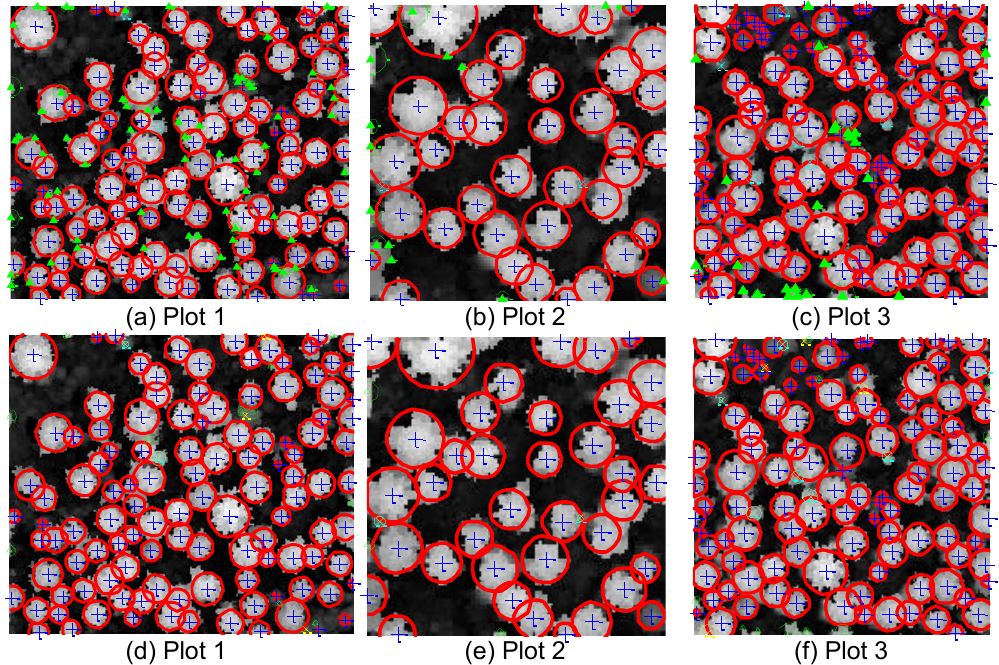
Figure 5: Detection results of the proposed model with estimated parameters compared with traditional local maxima filtering on experimental forest plots. (a)-(c) show the local maxima filtering results; (d)-(f) show the detection result of the proposed model using corresponding local maxima filtering detection as initial configuration. (Green circles with triangles in centre – commission errors; Cyan dot line circles – omission errors resulted from LM; Yellow circles – omission errors produced by the proposed model.) Table 1: Detection results of the proposed model (MPP) with estimated parameters compared with local maxima filtering (LM). Detected Overall Trees No. % No. No. % Quality